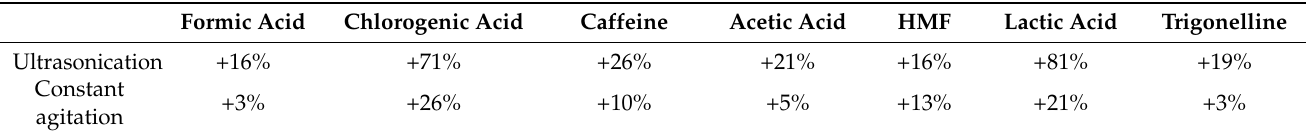
Table 4. Percentage increase in the amount of substance after a one-hour cold brew extraction with the specified method compared to an extraction without agitation.